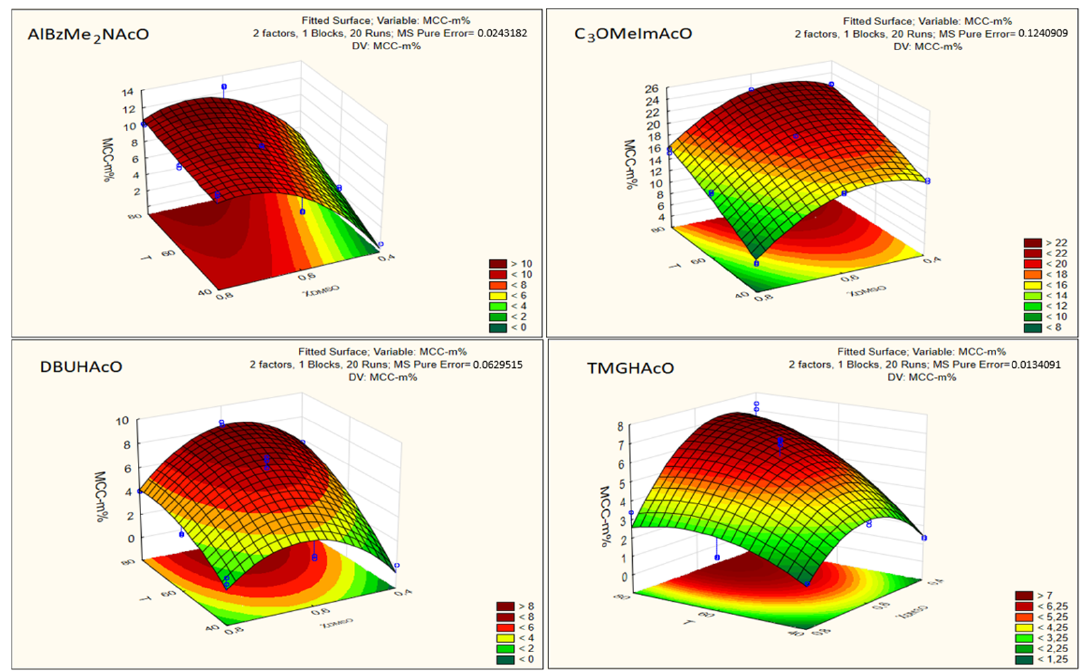
Figure 6. Response–surface plots for the dependence of the mass fraction of dissolved Cel (MCC-m%) on T and ( χ DMSO ). The color codes (green → yellow → red → deep red) indicate the increase of MCC-m% as a function of increasing the experimental variable.